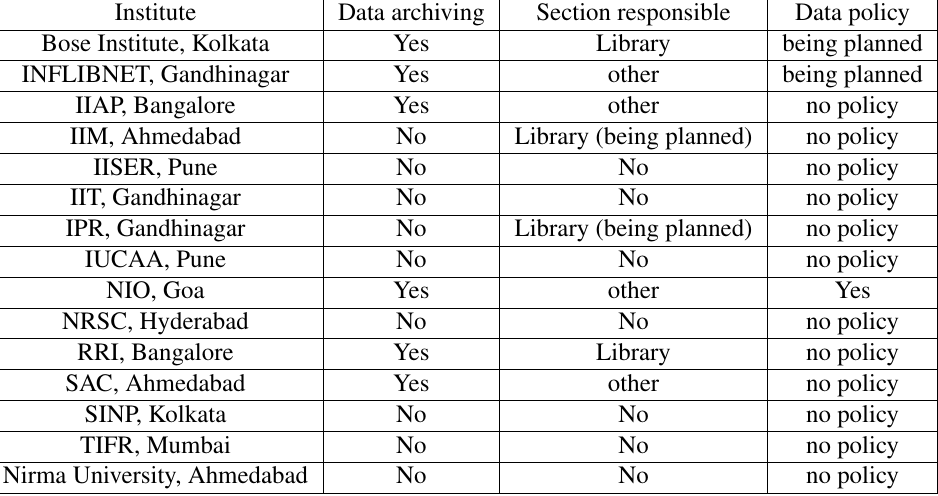
Table 1. Data archiving at various